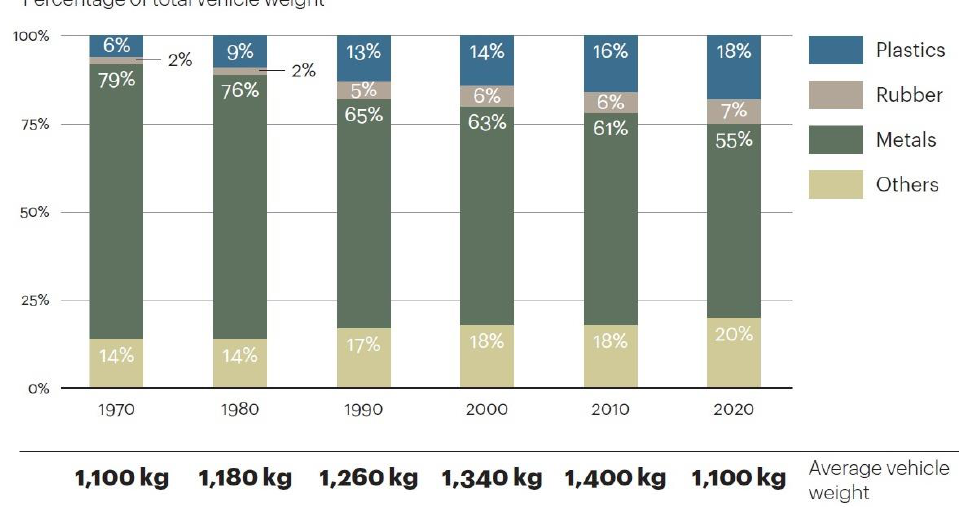
Figure 1. Material consumption of vehicles.